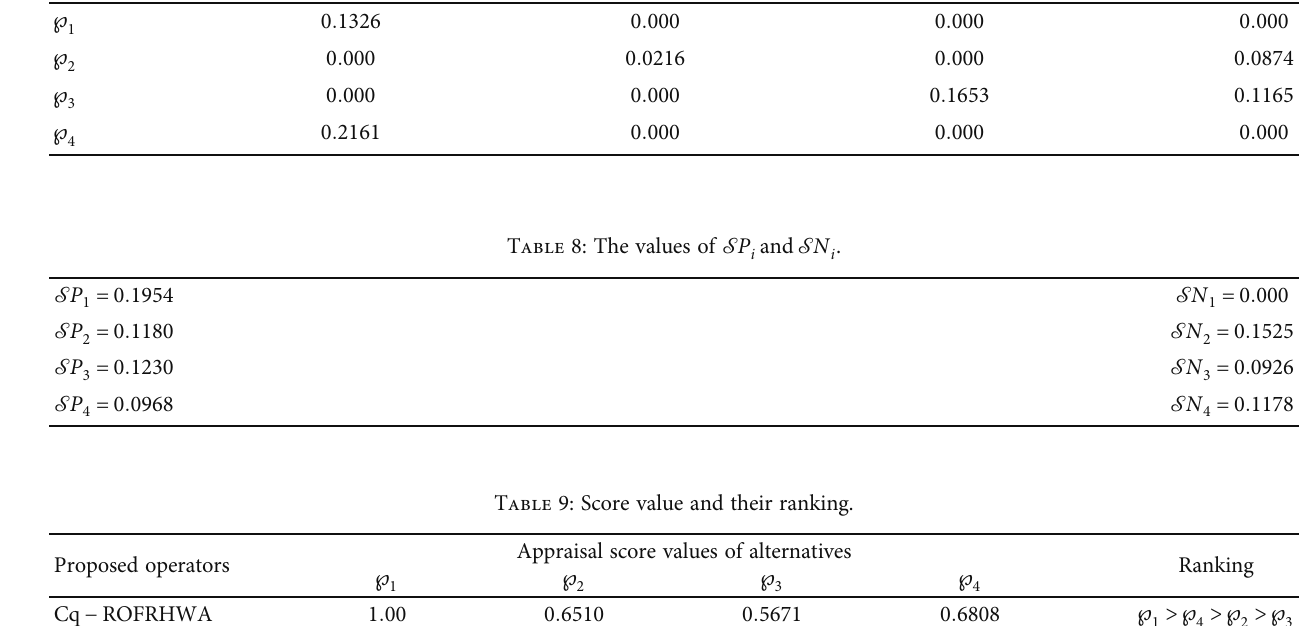
Table 7: The values of NDA S